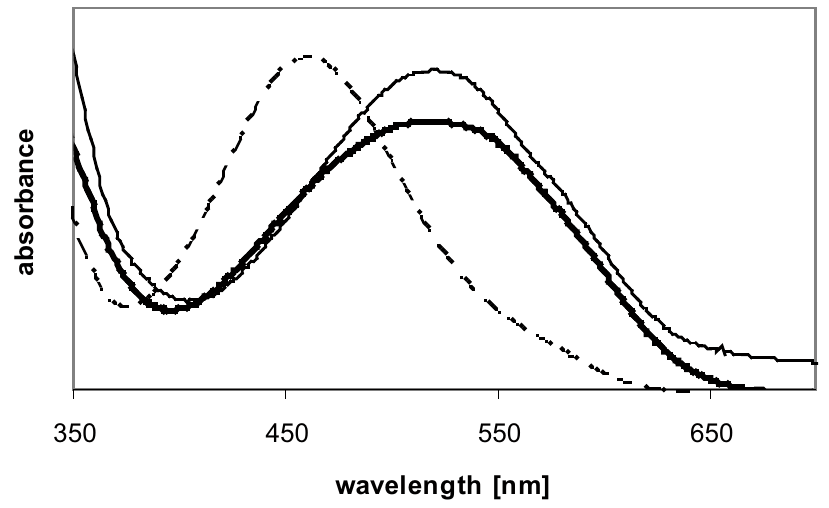
Figure 1. Absorbance of ARS in phosphate buffer ( ____ ); ARS with 4-formylphenylboronic acid ( _ _ _ ); ARS with 4-formylphenylboronic acid and glucose ( 